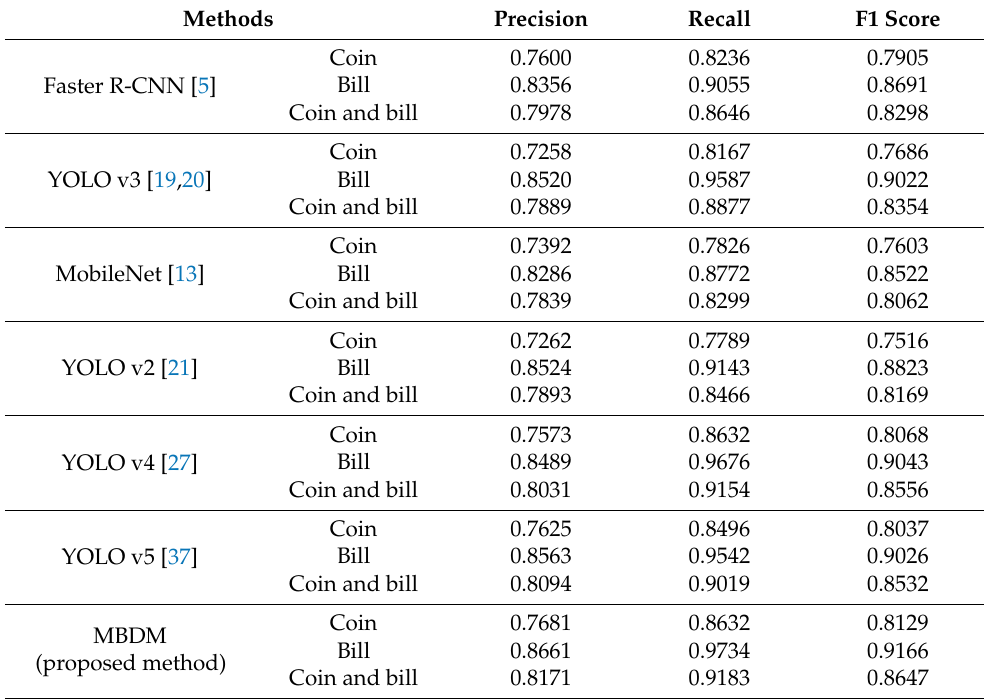
Table 11. Performance comparisons of the proposed method and the state-of-the-art methods with